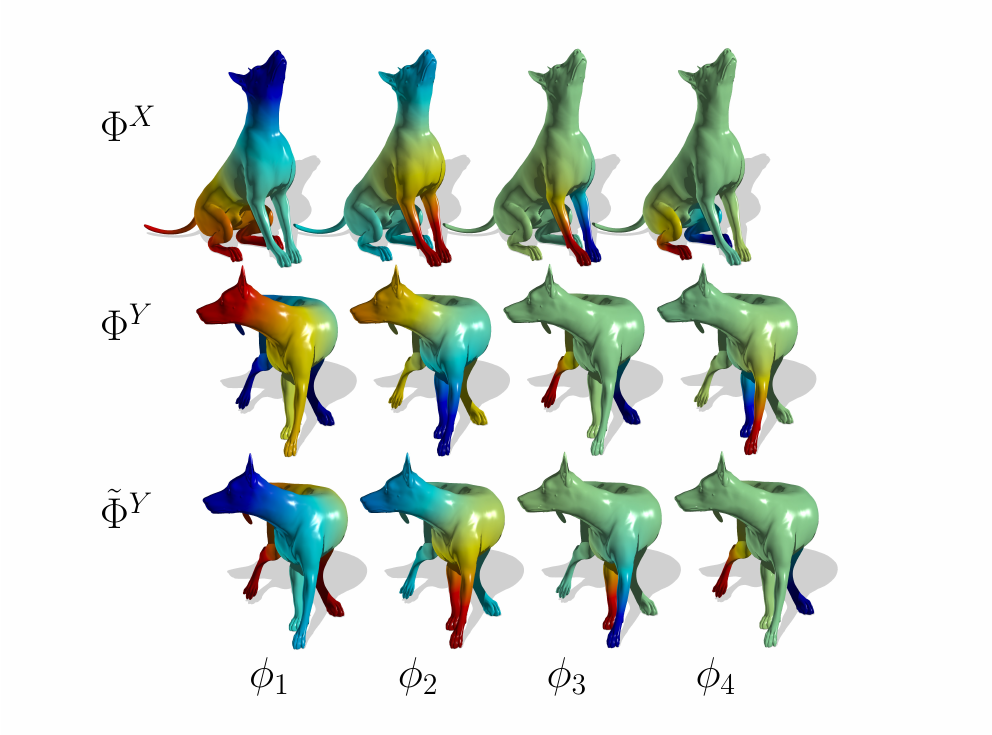
Figure 1. The eigenfunction matching of two nearly isometric shapes. Hot and cold colors represent positive and negative values, respectively. ( Top ) The first pose of a dog; ( center ) the second pose of a dog; ( bottom ) the second pose of a dog after the matching algorithm.